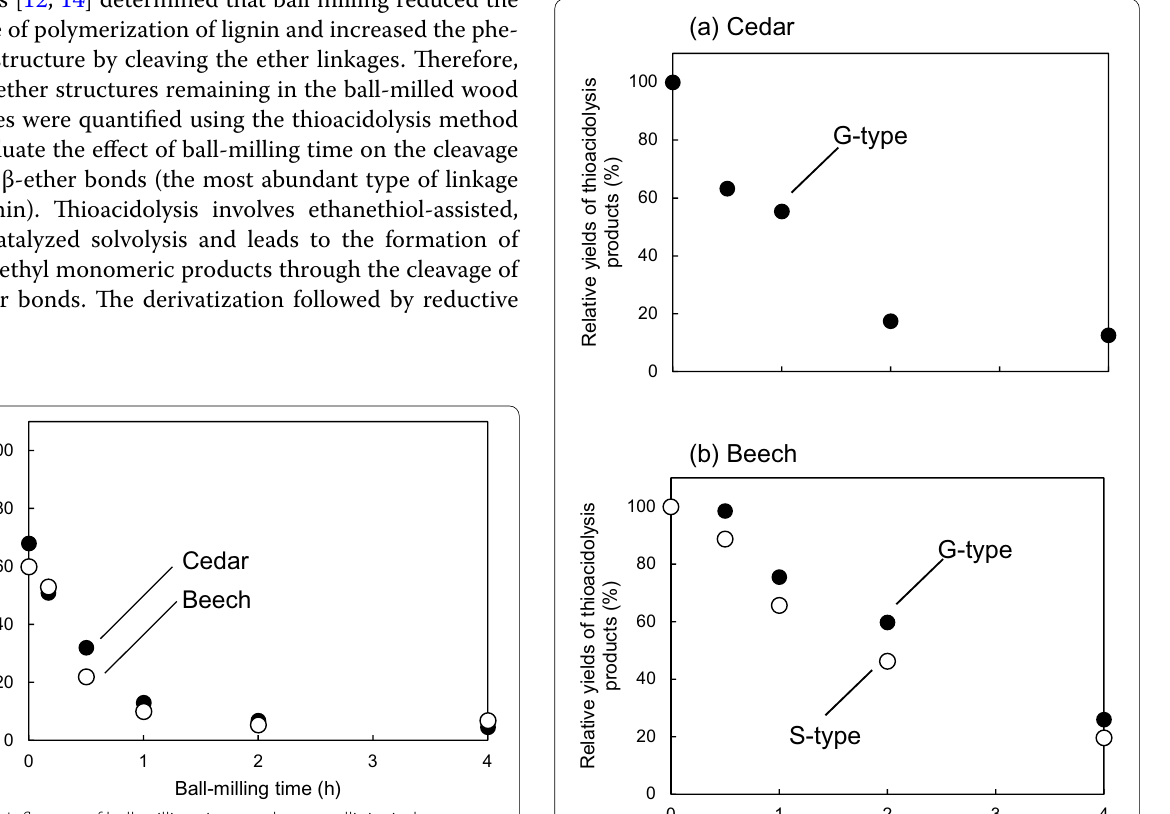
Fig. 2 Influence of ball-milling time on the crystallinity index evaluated by XRD analysis for cedar ( ) and beech ( ) wood Fig. 3 Influence of ball-milling time on the yields of thioacidolysis products from a cedar and b beech